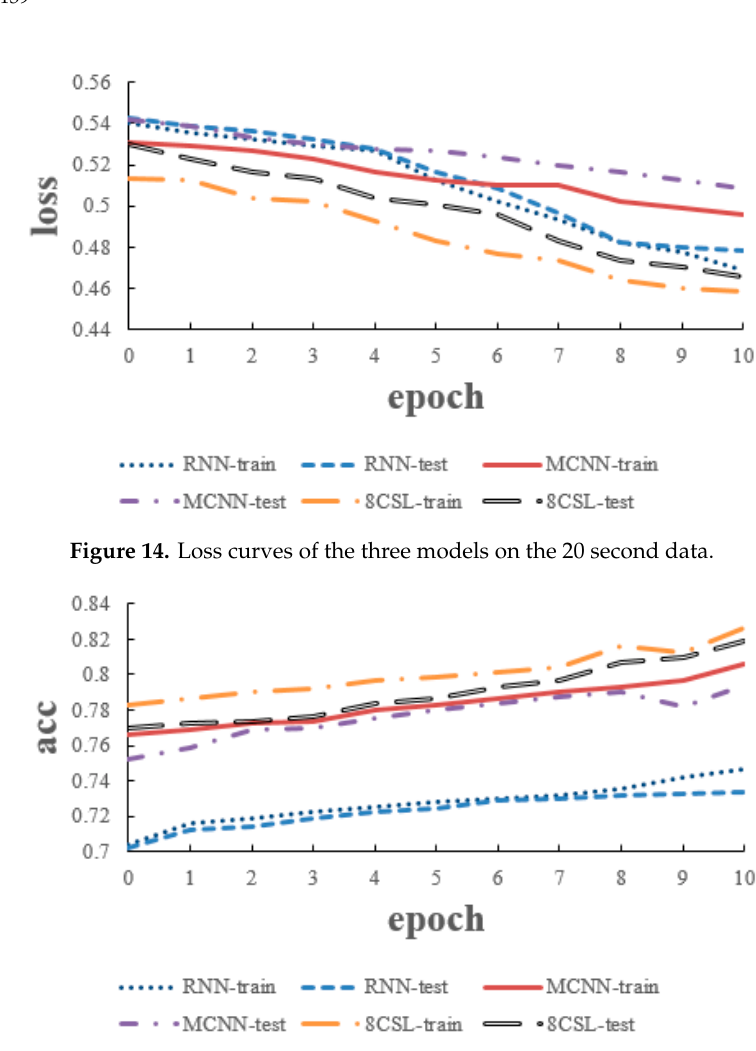
Figure 15. Accuracy curves of the three models on the 20 second data.